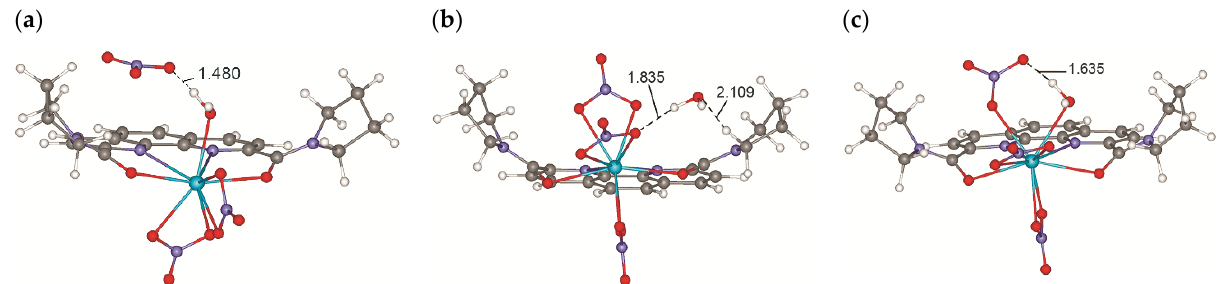
Figure 6. Structures of ( a ) {[ L4 Ln(NO 3 ) 2 H 2 O] + NO 3 − } ( A ), ( b ) [ L4 Ln(NO 3 ) 3 ] · H 2 O ( B ) and ( c ) [ L4 Ln(NO 3 ) 3 H 2 O] ( C ) complexes according to calculation data. The formation energies ∆ E of tight ionic pairs (Figure 7a) and hydrated neutral com- plexes (Figure 7b) for the whole series of Ln with ligands L4 and L5 and the differences of these energies ∆∆ E = ∆ E B − ∆ E A are presented in Supplementary Materials and in Figure 7. For chosen ligands, both ∆ E C and ∆ E B decrease from La 3+ to Lu 3+ (Figure 7a,b). As obvious,